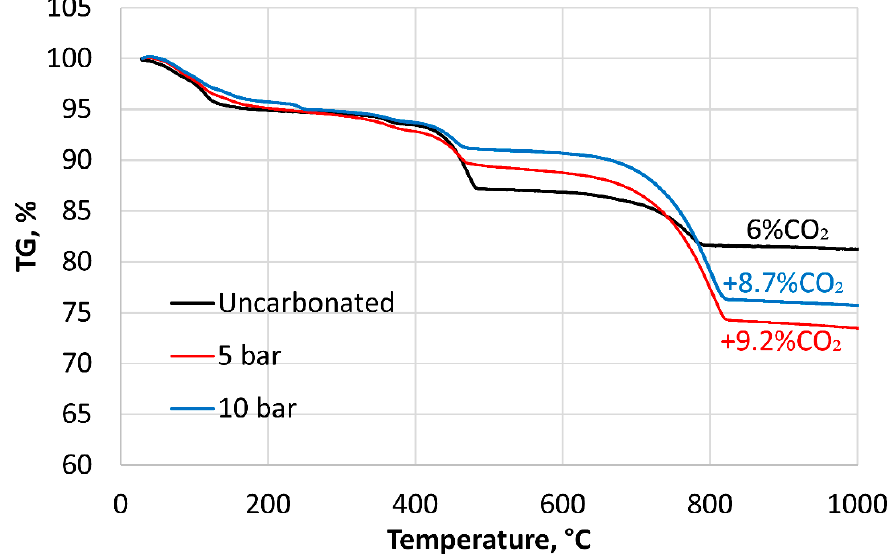
Figure 11. TGA curves for monoliths made from coarse fraction of APP EPA.